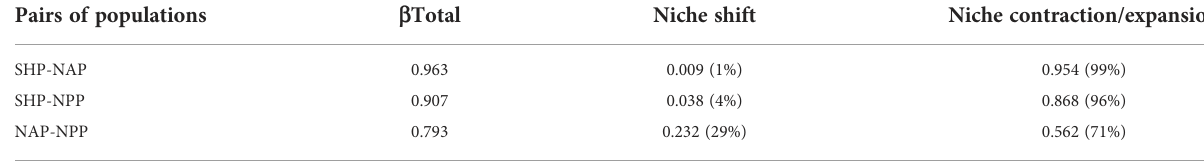
TABLE 4 Total niche differentiation ( b Total) between populations and the proportion of niche shift and niche contraction/expansion. Pairs of